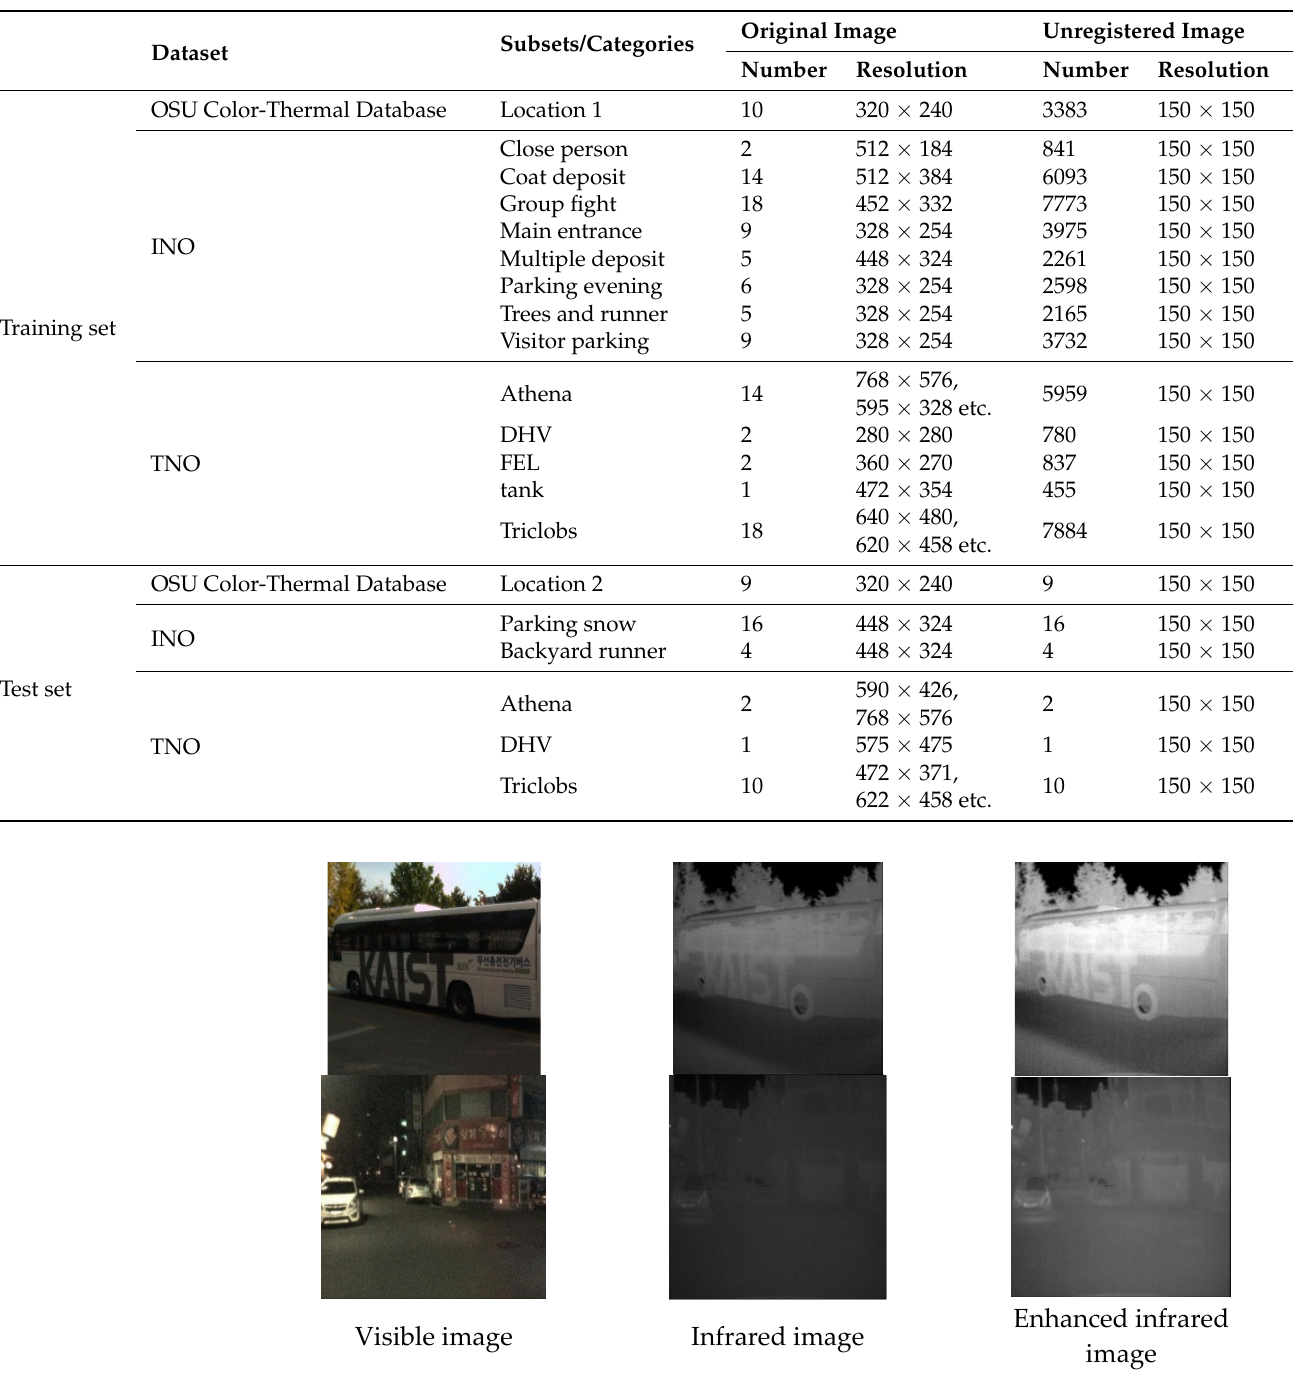
Figure 5. Infrared and visible image pairs from a moving camera in a real dataset. Column 1 is the visible image. Column 2 is the infrared image. Column 3 is the infrared image after image enhancement.